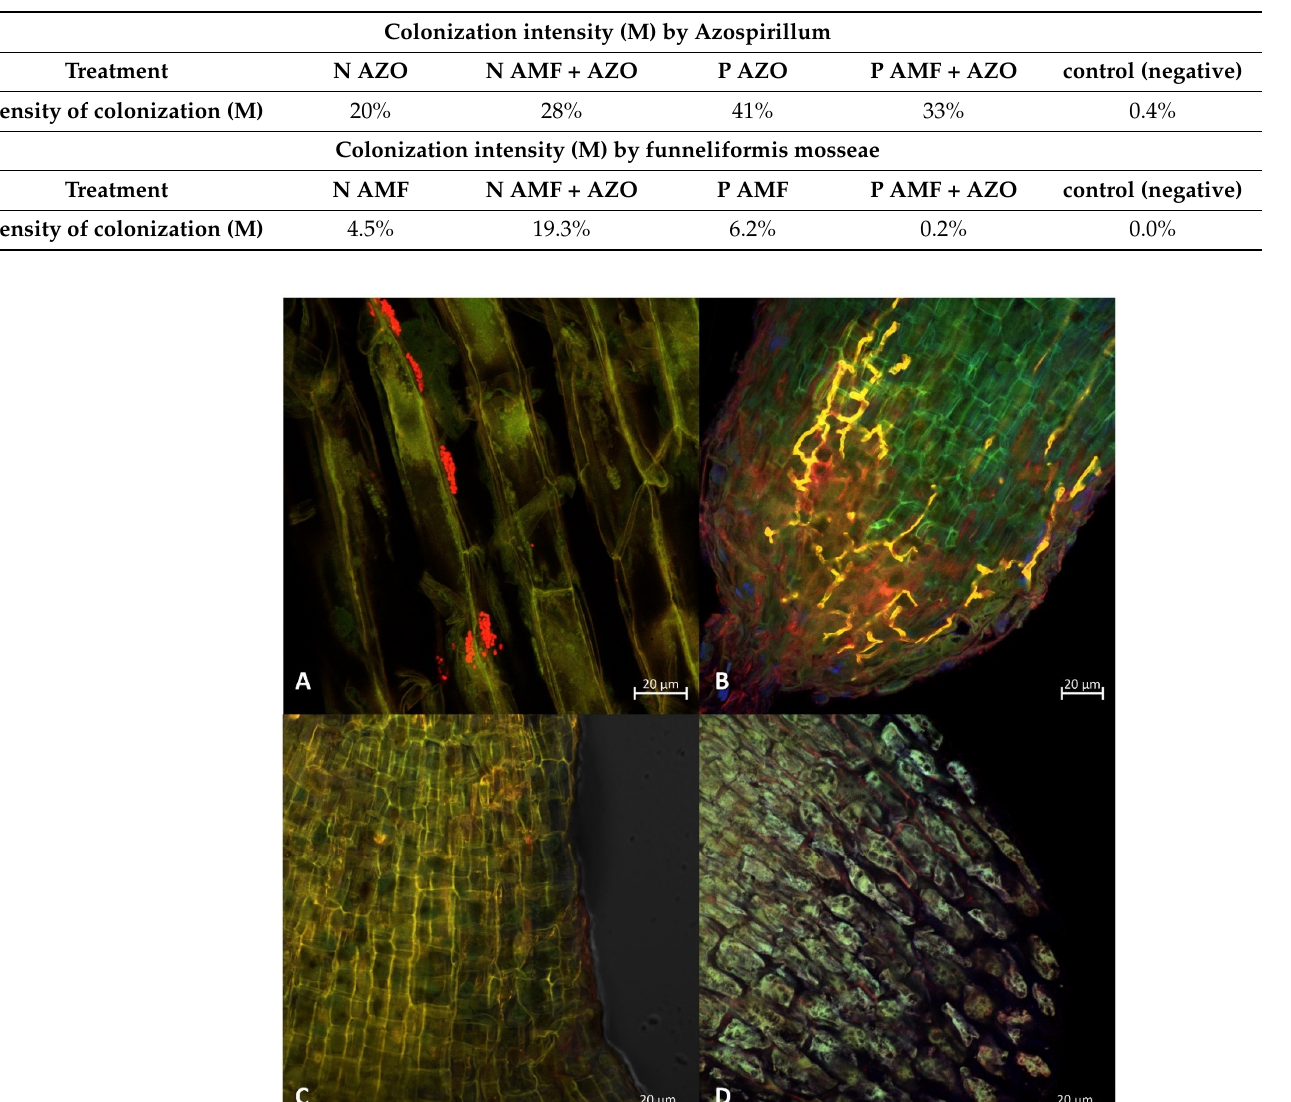
Table 4. Intensity of colonization (M) by Azospirillum brasilense (M) and Funneliformis mosseae within given treatments and non-treated control plants.